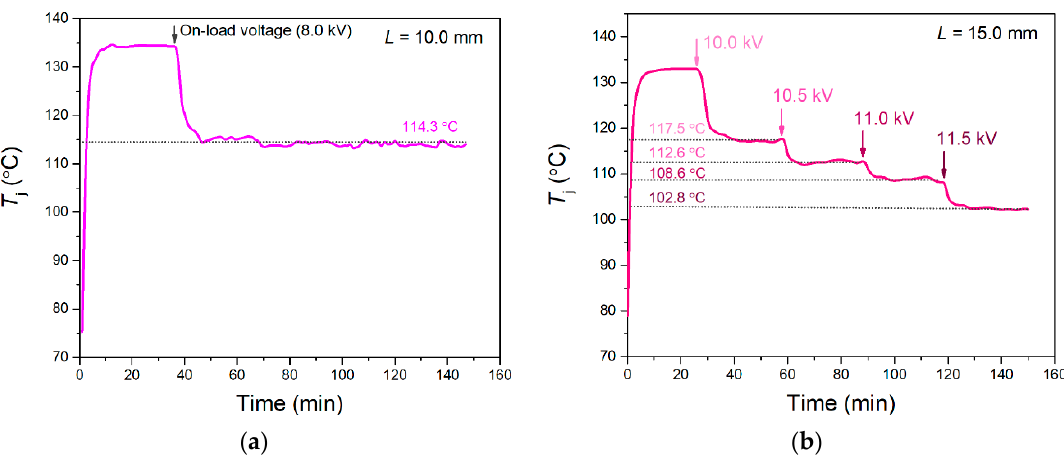
Figure 8. Stability and adjustability testing of ionic wind device: ( a ) continuous working for 100 min; and, ( b ) successive increasing applied voltage.